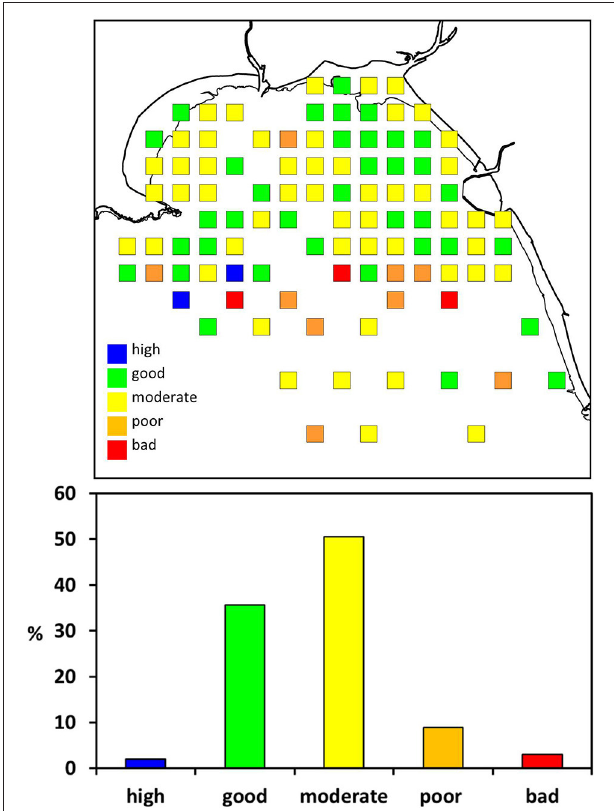
FIGURE 5 | Water Framework Directive (WFD) classification of benthic infauna in Swansea Bay according to the Infauna Quality Index (IQI). It is a combination index based on three individual components: AZTI Marine Biotic Index (AMBI), Simpson’s Evenness (1- λ ′ ), and number of taxa